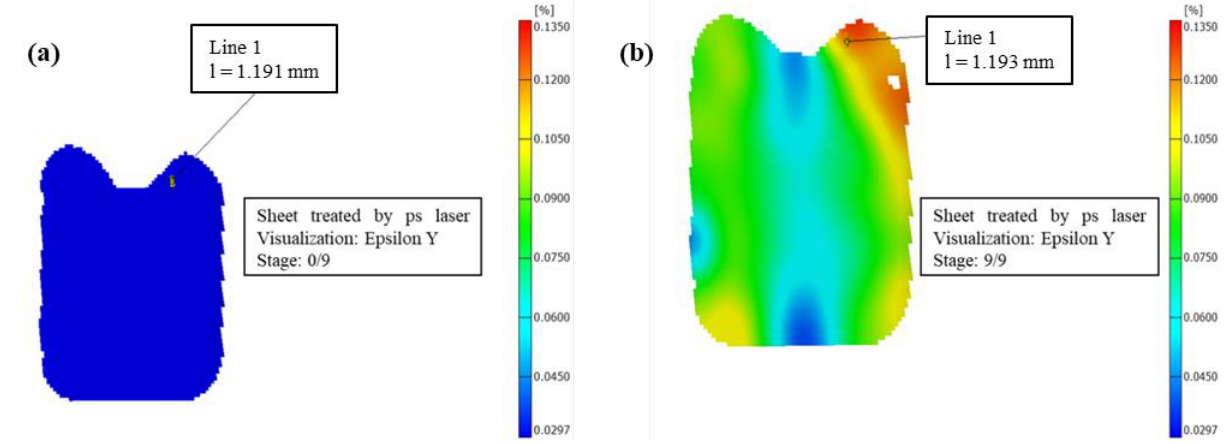
Figure 8. Nimonic 263 sheet, treated by ps laser DIC measurement 1: ( a ) unloaded state, and ( b ) axial force 5 kN.